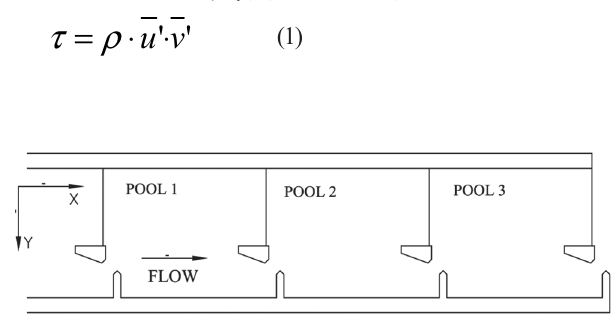
Fig.1. Scale model of vertical slot fish